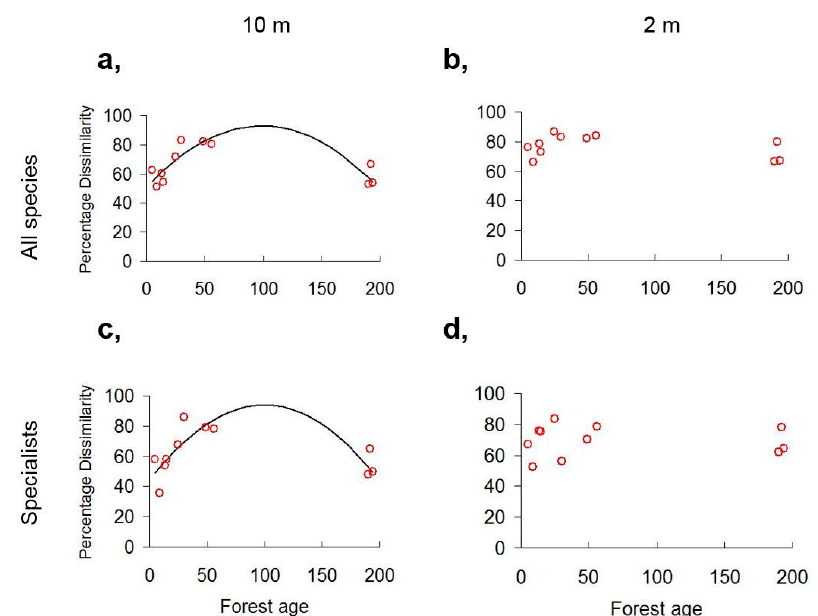
Figure 3. Beta diversity along the chronosequence represented by Bray–Curtis Percentage Dissimilarity. Significant quadratic models are shown. (a) For all species at 10 m scale: Y = − 0.0043 x 2 + 0.8514 x + 50.780 (R 2 = 0.7227 p < 0.05). (c) For specialists at 10 m scale: Y = ‐ 0.005 x 2 − 0.998 x + 43.992 (R 2 = 0.6257 p < 0.05). (b)(d) show non ‐ significant relationships.